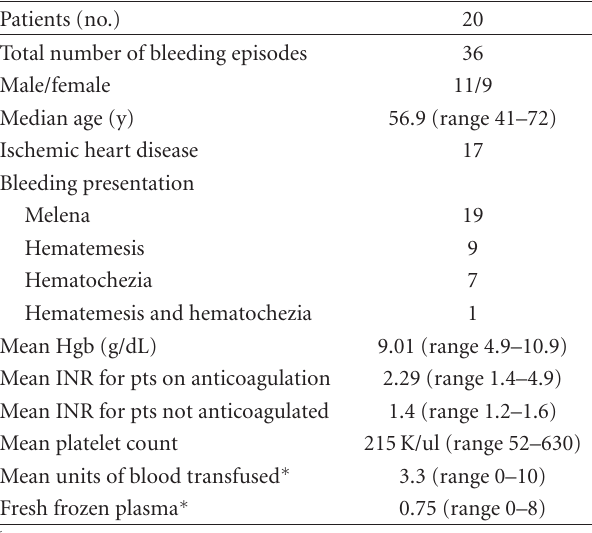
Table 1: Demographic data in 20 VAD patients admitted for overt GI